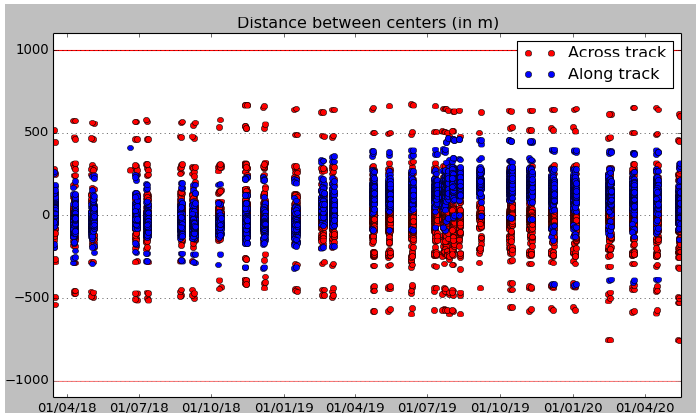
Figure 20. Along-track (ALT) and across-track (ACT) pointing performances through VM01 phase. In red: steering performance requirement (1000 m ACT, 3000 m ALT).